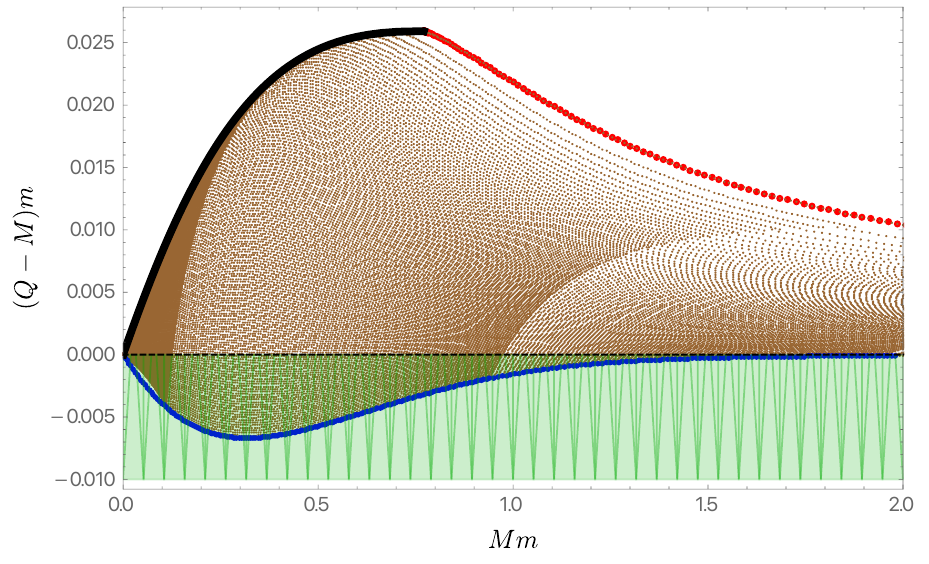
Figure 1 . The phase diagram of solutions with q/m = 1 and α = 1 . RN black holes exist in the green area with Q − M ≤ 0 , with the dashed horizontal line at Q − M = 0 being the extremal RN family. Hairy black holes exist in the brown shaded region. They begin at the blue line which denotes the onset of the scalar instability. They are bounded on top by either the red curve which represents nonsingular maximal warm holes with µ = 1 , or the black curve which denotes singular extremal hairy black holes (with T = 0 and S = 0 ). Note that hairy black holes can slightly exceed the usual extremal bound Q = M